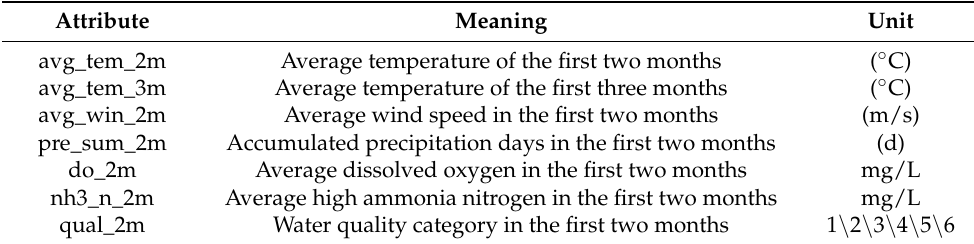
Table 2. Meteorological and water quality